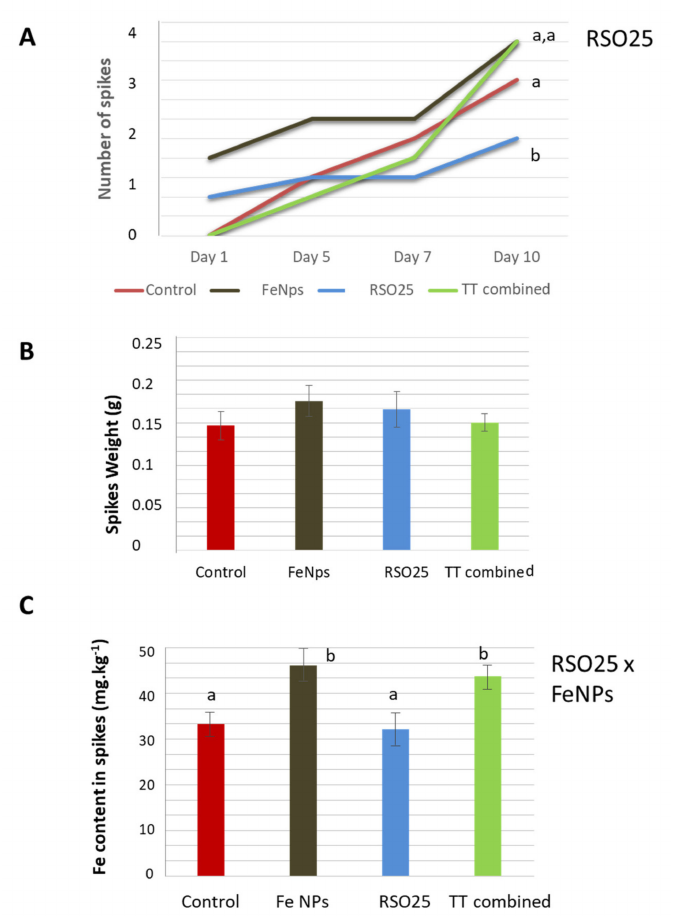
Figure 5. Kinetics of spikes outgrow ( A ), biomass of spikes ( B ), and Fe content in spikes ( C ) of Triticum aestivum plants treated with metallic Fe-containing polymeric nanoparticles (FeNPs), inoculated with Bacillus aryabhattai (RSO25) and exposed to the combination of both treatments (TT Combined) for 45 days. Values represent means ± SD, n = 12. RSO25, FeNPs or their interactions in the corner of the panel indicate main or interaction significant effects. Different letters indicate means that are significantly different from each other (LSD test, p < 0.05). In the case of Figure 5A, the letters correspond to data of day 10 after spike